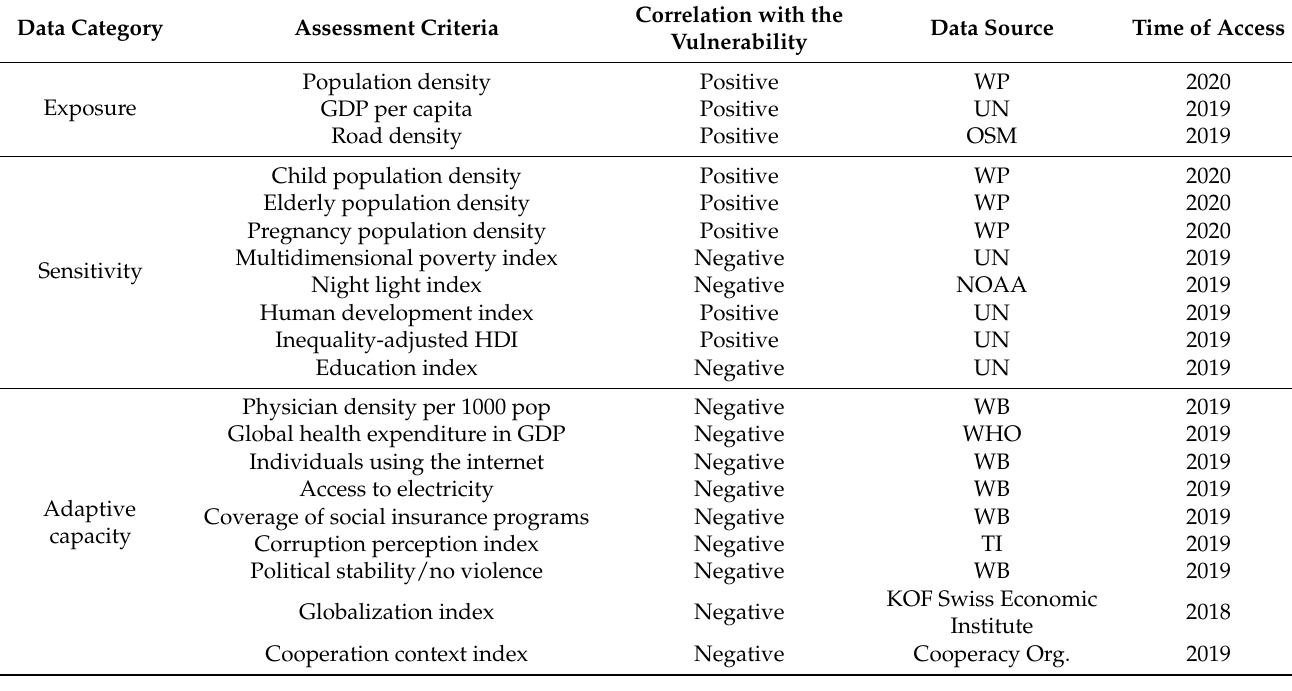
Table 3. Vulnerability data for watershed scale.